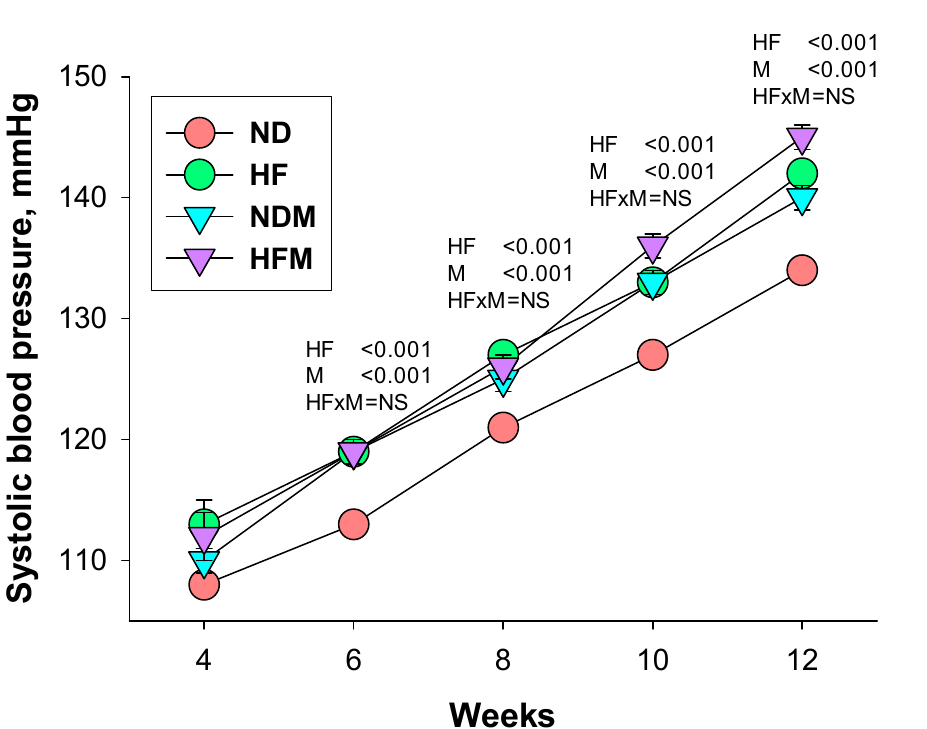
Figure 1. Effect of high-fructose diet (HF) and minocycline administration (M) on systolic blood pressure in offspring from 3 to 12 weeks of age. HF × M = the interaction between high-fructose diet and minocycline. Table 2. Plasma and fecal short chain fatty acid (SCFA)